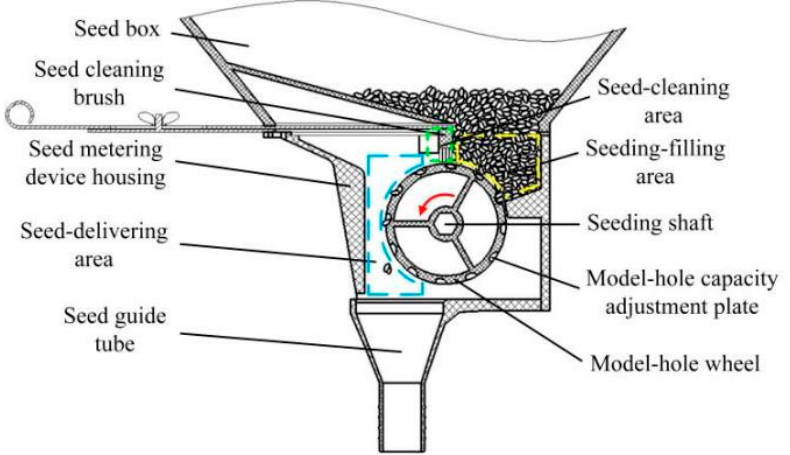
Figure 2. Seed metering device for wheat.